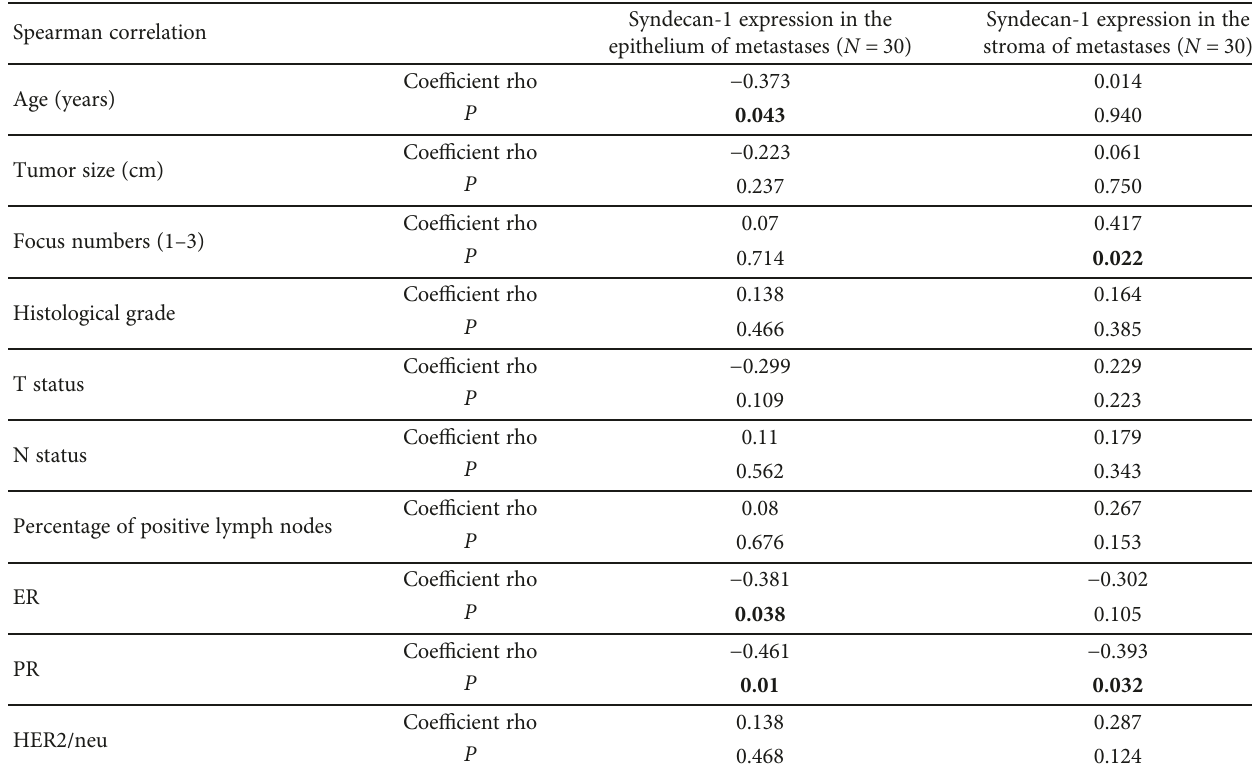
Table 5: The correlation between the Sdc1 expression in the tumor epithelium and the stroma of the metastases of the ductal breast carcinoma and some clinical and histological features of the primary tumors, analyzed using Spearman ’ s correlation coe ffi cient. Spearman